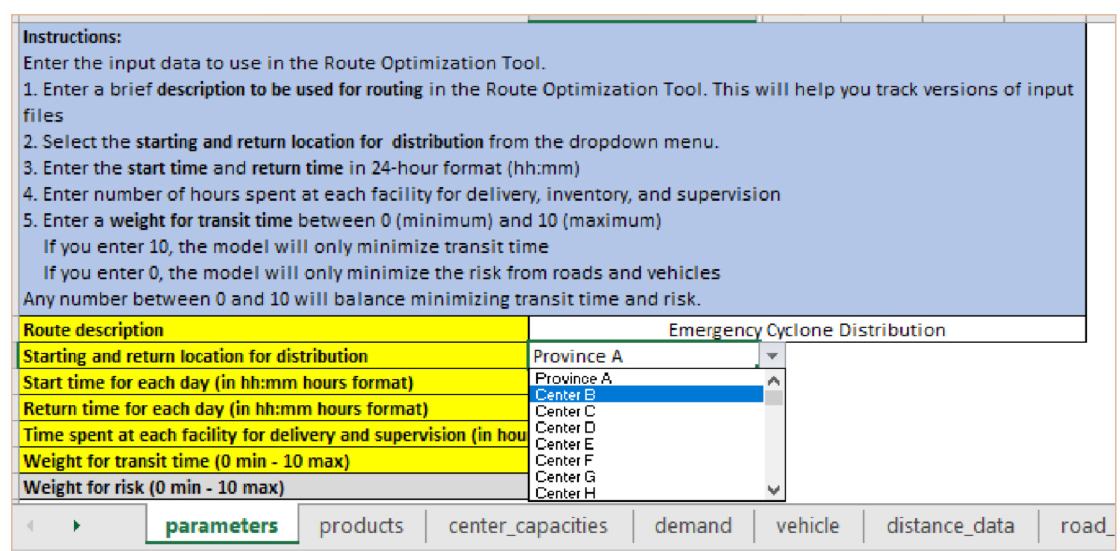
quickly determine, and plan routes based on minimizing transit time and risk, to align with government